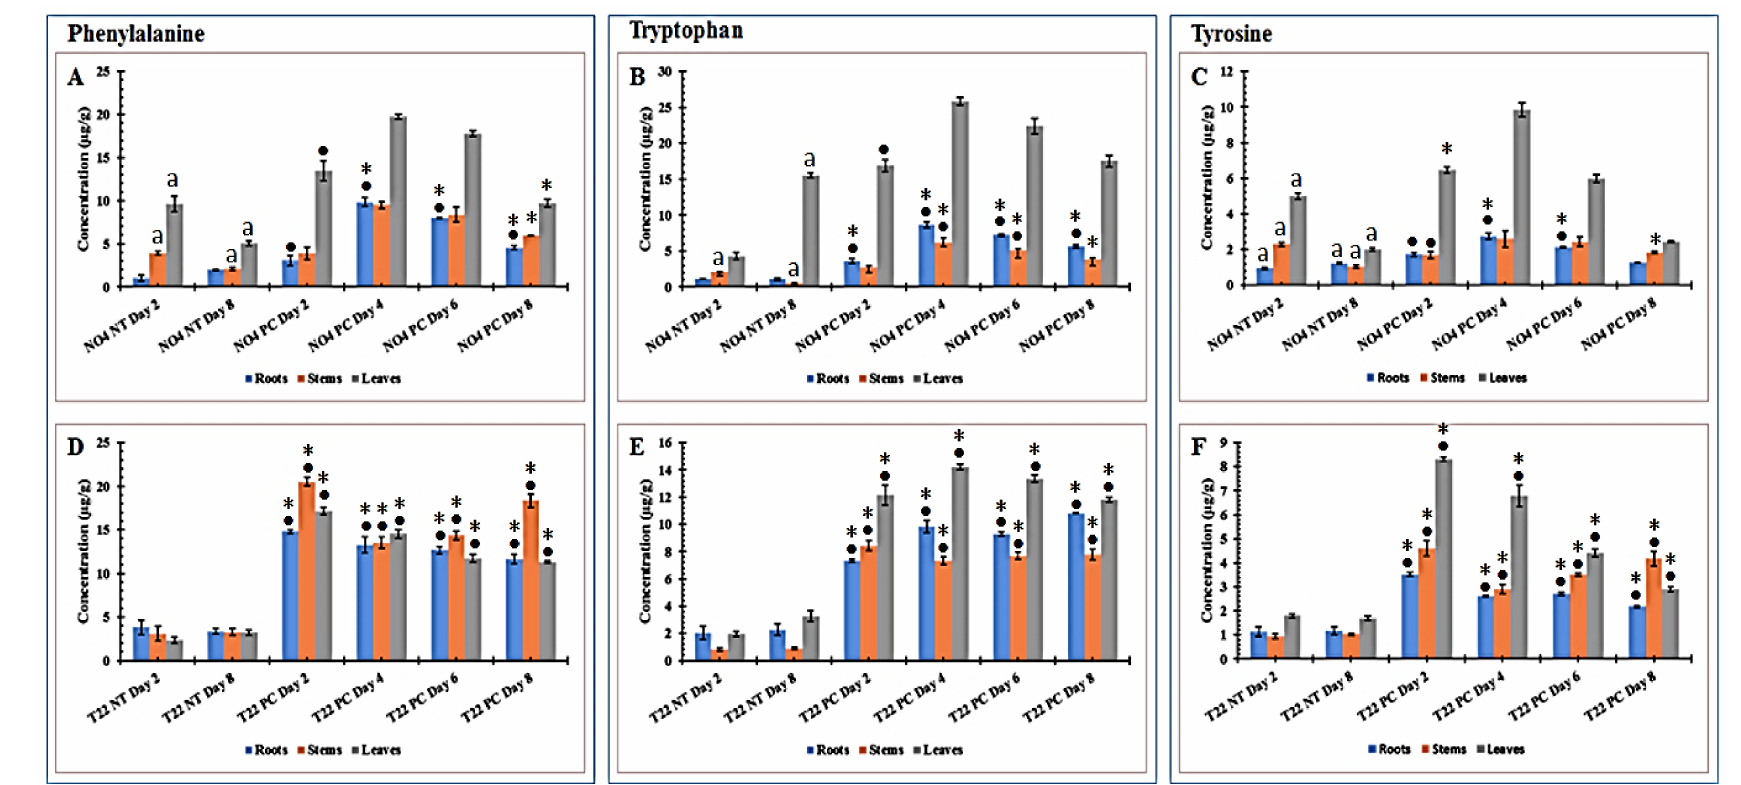
Figure 2. Changes in aromatic amino acids in PGPR primed tomato plant tissues harvested at different time points following Phytophthora capsici inoculation. ( A – C ) Pseudomonas fluorescens N04 primed-unchallenged (NT) vs. Ps. fluorescens primed-challenged (PC), ( D – F ) Paenibacillus alvei T22-primed-unchallenged vs. Pa. alvei primed-challenged. All concentrations are expressed as µ g/g fresh weight (FW). Non-treated (NT) controls at the start (day 2) and end (day 8) of the time series were included. Comparing the PGPR-primed-unchallenged plants and the primed-infected plants, a dot ( • ), asterisk (*) or letter (a) indicates the statistical significance (ANOVA followed by Tukey post-hoc test at a p -value < 0.05) (Table S5): • indicates a comparison between NT day 2 and the various primed-challenged plants on days 2–8 and * indicates a comparison between NT day 8 and the various primed-challenged plants on days 2–8. The letter “a” indicates a statistically significant difference between the NT controls on days 2 and 8. The results show a time-dependent differential reprogramming of aromatic amino acid levels by Ph. capsici in the various